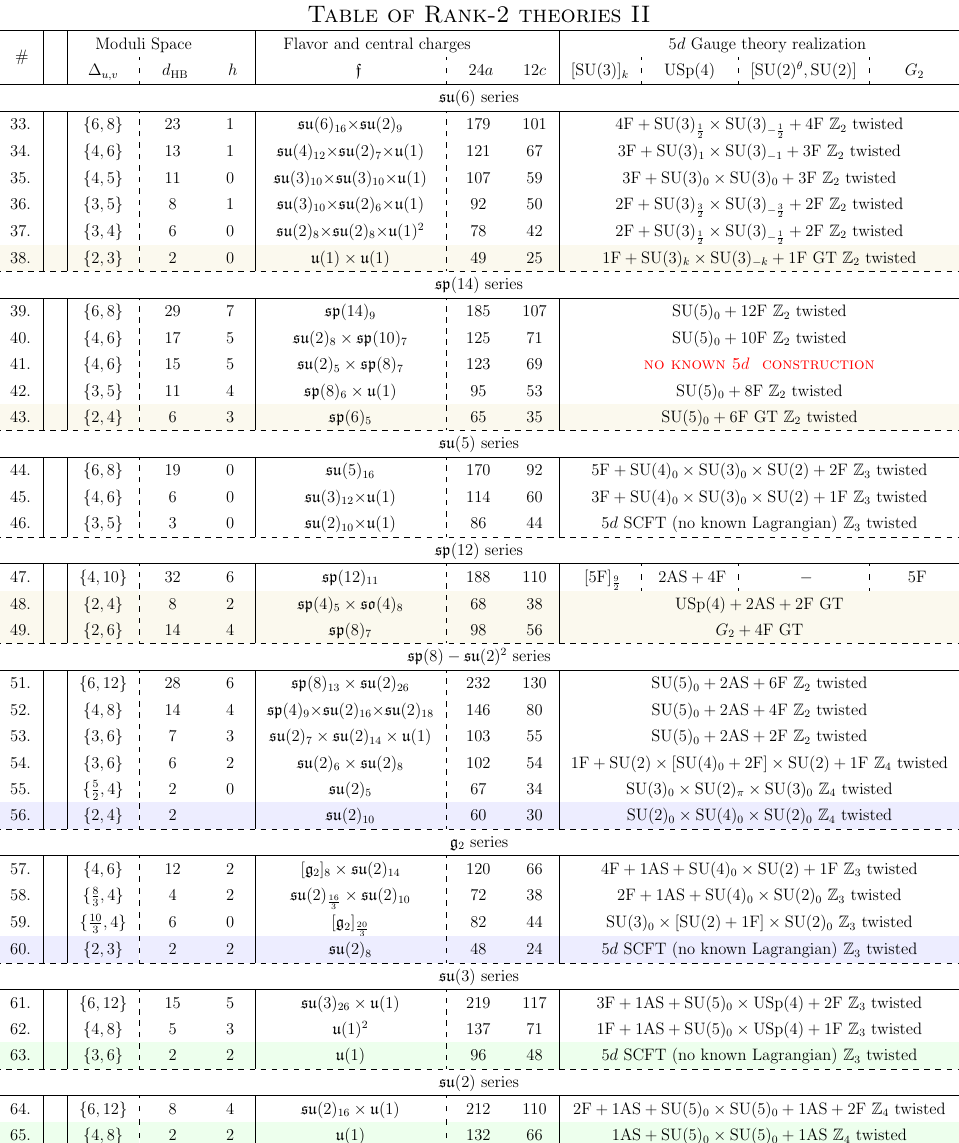
Table of Rank-2 theories II